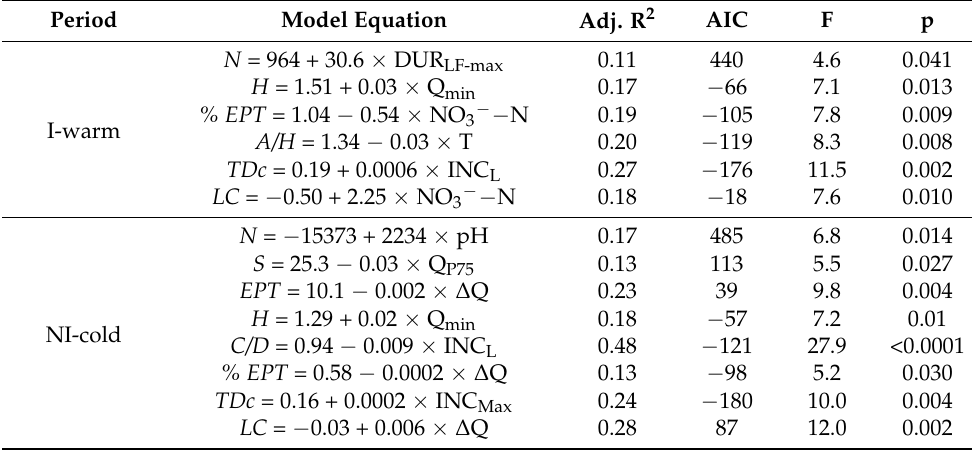
Table 3. Significant results of the OLS regression (best model selected according to the Akaike information criterion—AIC, constraining the result to one independent variable) carried out for each benthos metric, accounting for all the considered environmental (hydrological and physico- chemical) variables. The coefficient of determination adjusted (Adj. R 2 ), the F-statistic, and model significance are also reported. I-warm = Irrigation and warm period, NI-cold = Non-Irrigation and cold period. N = total density of macroinvertebrates, S = family richness, H = Shannon-Wiener diversity index, EPT = richness of EPT taxa , %EPT = relative abundance of EPT taxa , C/D = the ratio of Chironomidae/Diptera individuals, A/H = auto/heterotrophy, TD c = top-down control, LC = life cycle, DUR LF-max = maximum duration of low flows, Q min = minimum value of flow, INC L = last flow increase between two consecutive days, Q P75 = 75th flow percentiles, ∆ Q = difference between maximum and minimum flow, INC Max = maximum flow increase between two consecutive days, T = temperature, NO 3 − − N = nitrate